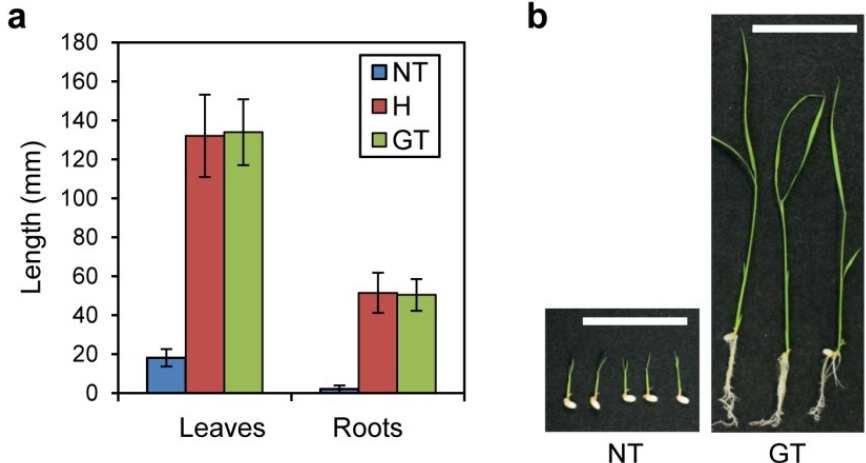
Figure 2. Sensitivity of non-transformant and GT plants to 5MT. Plants were grown in the presence of 250 μ M 5MT for 10 days. ( a ) Length of leaves and roots in non-transformants (NT) and plants homozygous (GT) and heterozygous (H) for the modified OASA2 gene in the T generation. Values are average ± SD (NT n = 9, H n = 14, GT n = 8). 2 ( b ) Photographs of 10-day-old NT and GT plants grown under 250 μ M 5MT conditions. Bars = 5